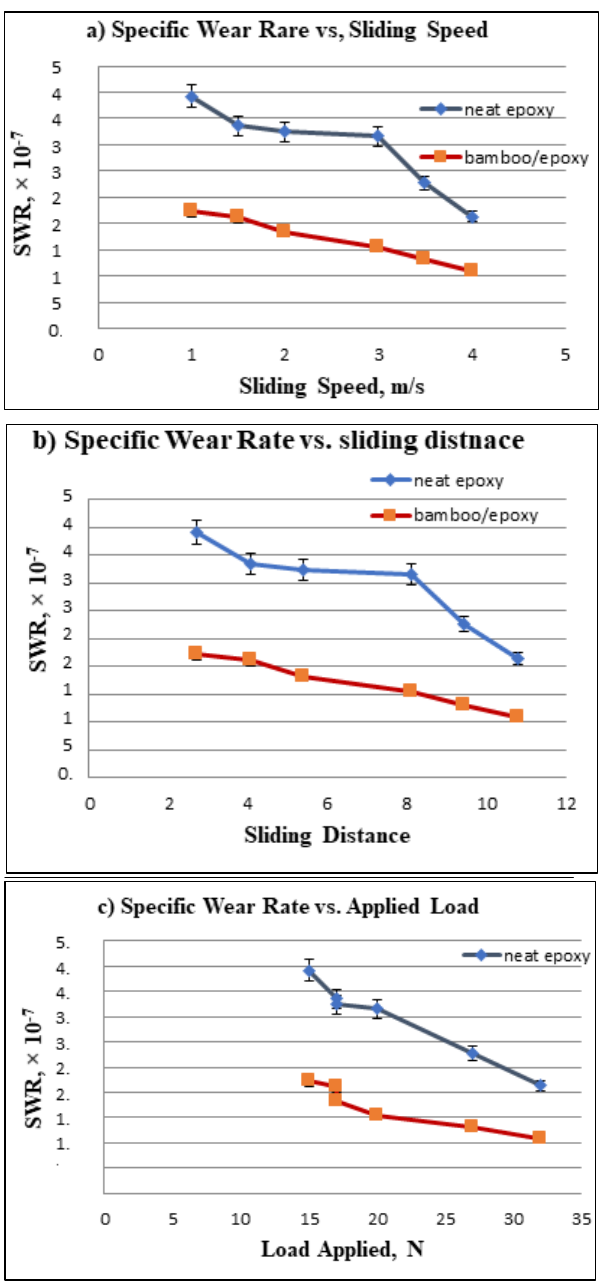
Figure 7 . Relationship between specific wear rate (SWR) and sliding distance, sliding speed and applied load.